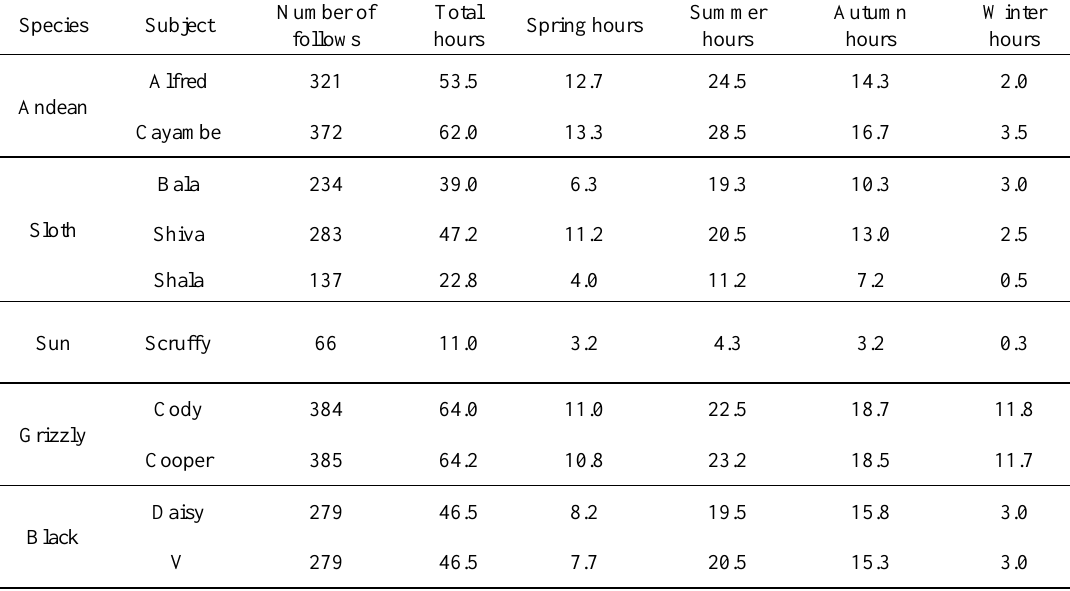
Number of Hours of Data Collected per Individual, Across All Seasons